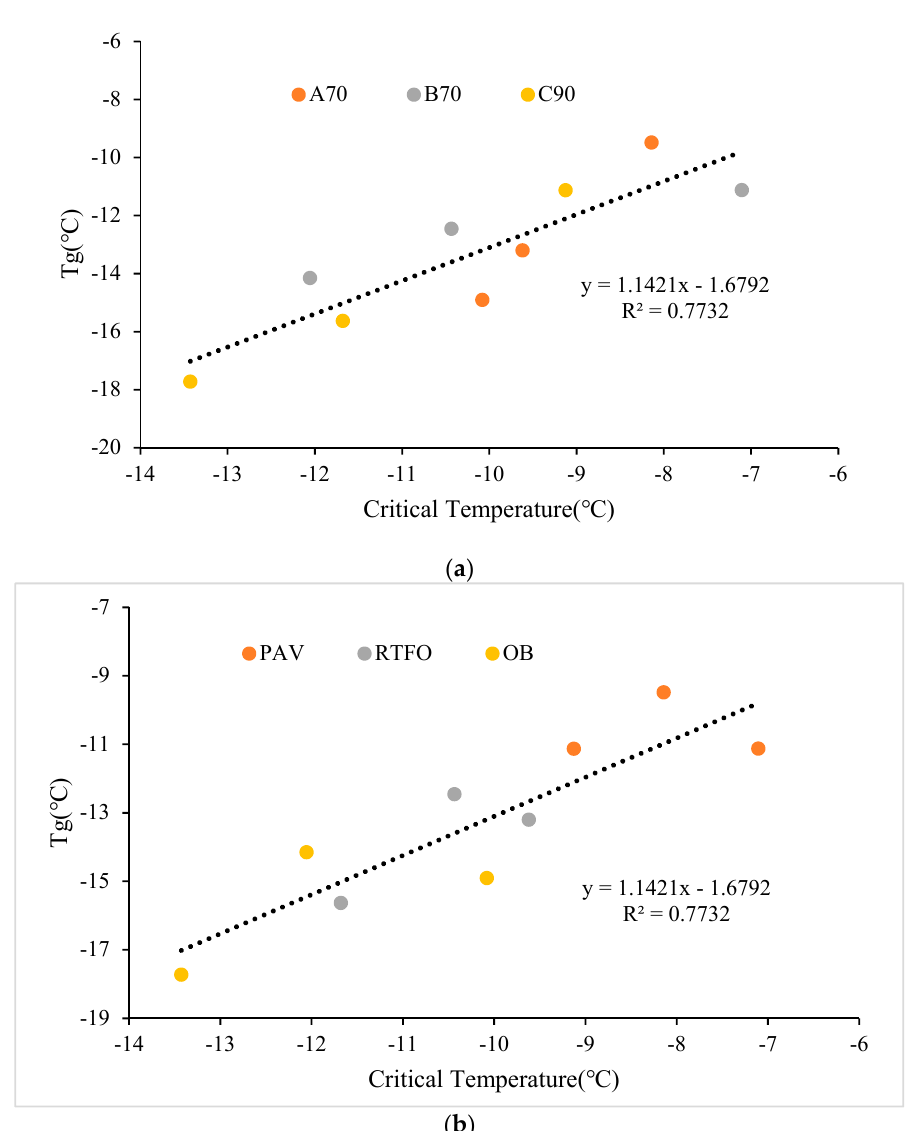
Figure 9. The relationship between critical temperature and T g . ( a ) base binders. ( b ) different aging states.